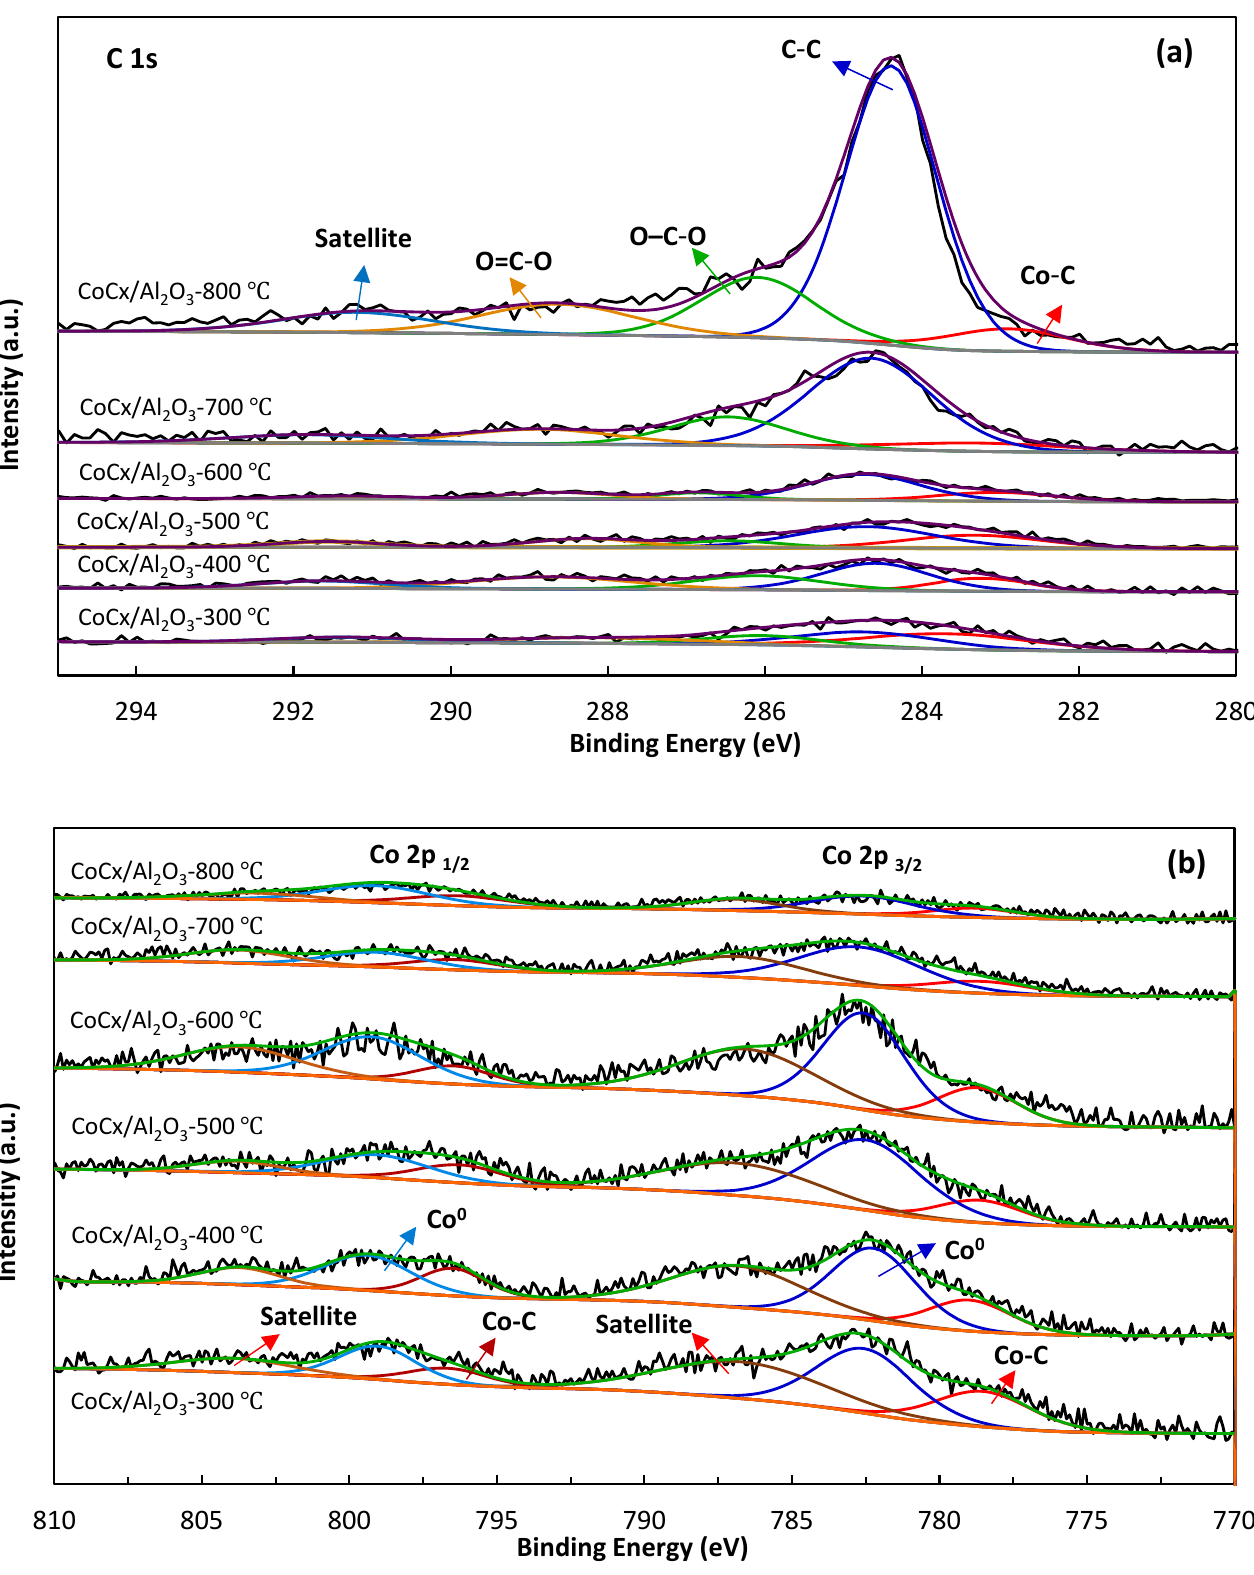
Figure 3. ( a ) C 1s spectra, and ( b ) Co 2p spectra of CoC x /Al 2 O 3 catalysts prepared at different tem- peratures.